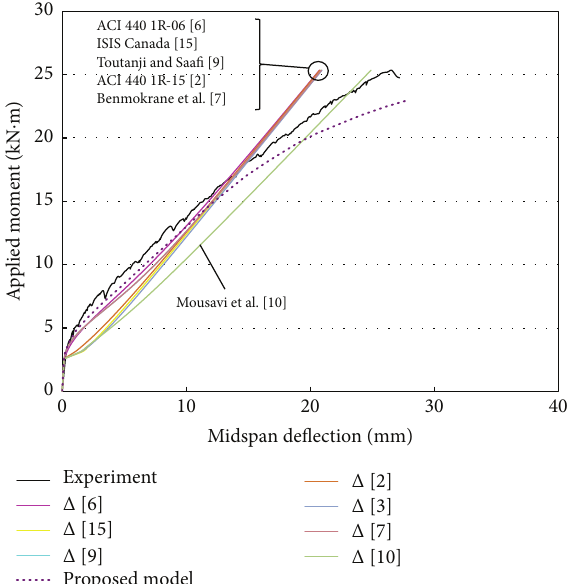
Figure 10: Moment-midspan deflection of FB-3.